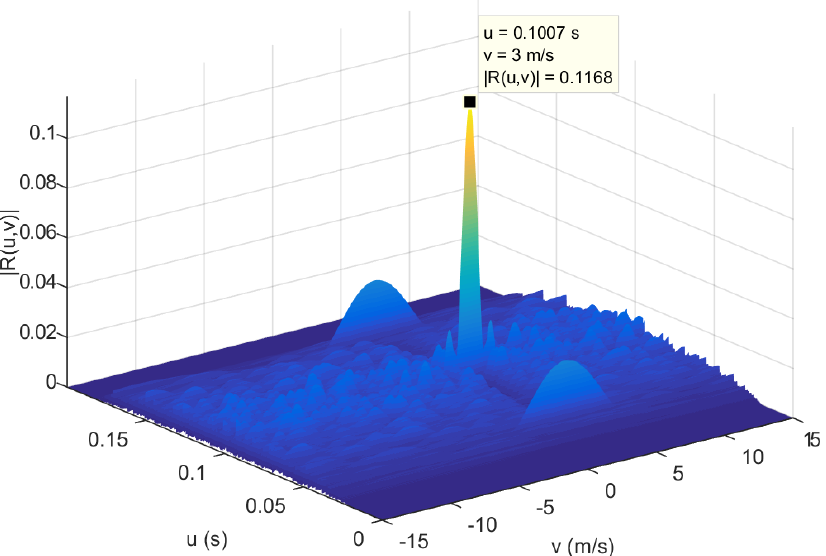
Figure A1. Bank filter simulation result R ( u , v ) (Passband 16–20 kHz, v 0 = 3 m/s, u 0 = 0.1 s), AWGN